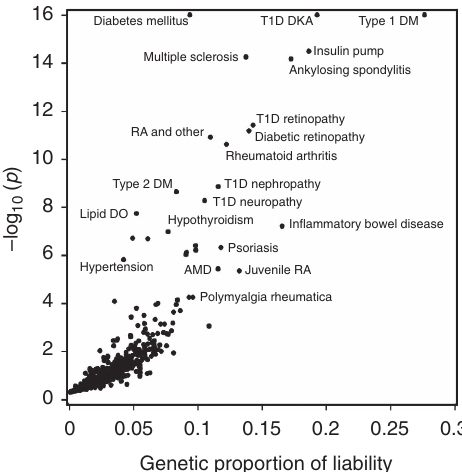
Figure 1 | Genetic liability estimates and P -values for PheWAS phenotypes. Each point represents the results from a mixed-models analysis using all SNPs with MAF 4 0.01 on the exome chip, adjusted for age, sex and 20 principal components. PheWAS phenotypes with P -values o 10 (cid:3) 16 (3 phenotypes) were set to 10 (cid:3) 16 for display purposes. Phenotypes with a genetic liability estimate o 0 are not shown. NATURE COMMUNICATIONS|7:11433|DOI: